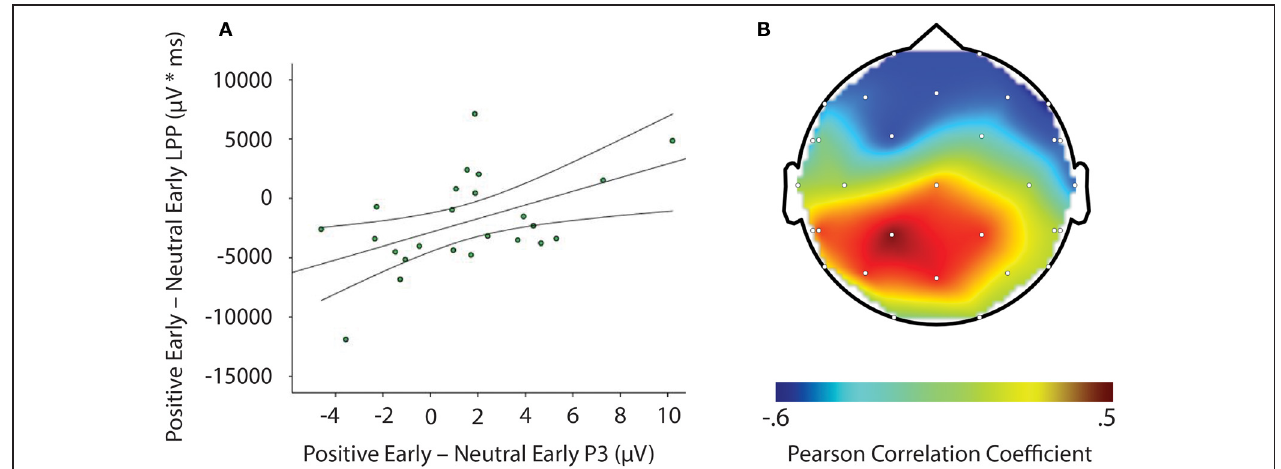
FIGURE 6 | Image signifying: (A) Correlation of difference scores from positive early minus neutral early conditions for P3 amplitude and LPP amplitude ∗ time. (B) A topographic representation of correlations between P3 amplitude and LPP difference scores from positive early minus neutral early conditions